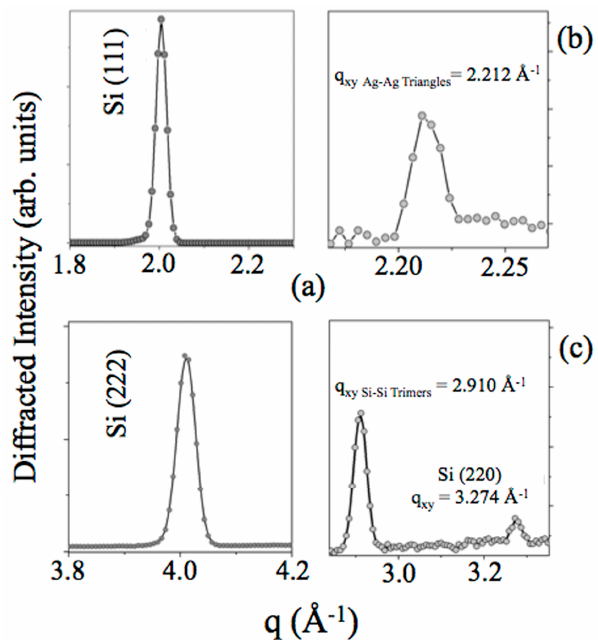
Figure 5. ED-GIXRD pattern of Si(111) √ 3–Ag substrate. ( a ) Si Diffraction peaks (q z ) are labeled accordingly to JCPDS N. 27-1402. ( b ) The Ag–Ag triangles reflection at q xy Ag-Ag Triangles = 2.212 (5) Å − 1 is shown. ( c ) The Si(220) q xy = (3.274 ± 0.005) Å − 1 and the in-plane Si–Si trimers q xy Si-Si Trimers = 2.91 Å − 1 are